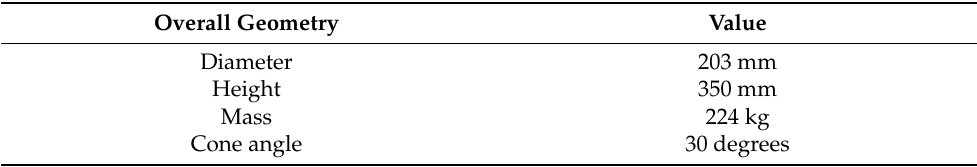
Figure 3. CZM model of ice projectile. Bulk elements are shown in dark and cohesive elements in light. Table 4. Geometry of ice